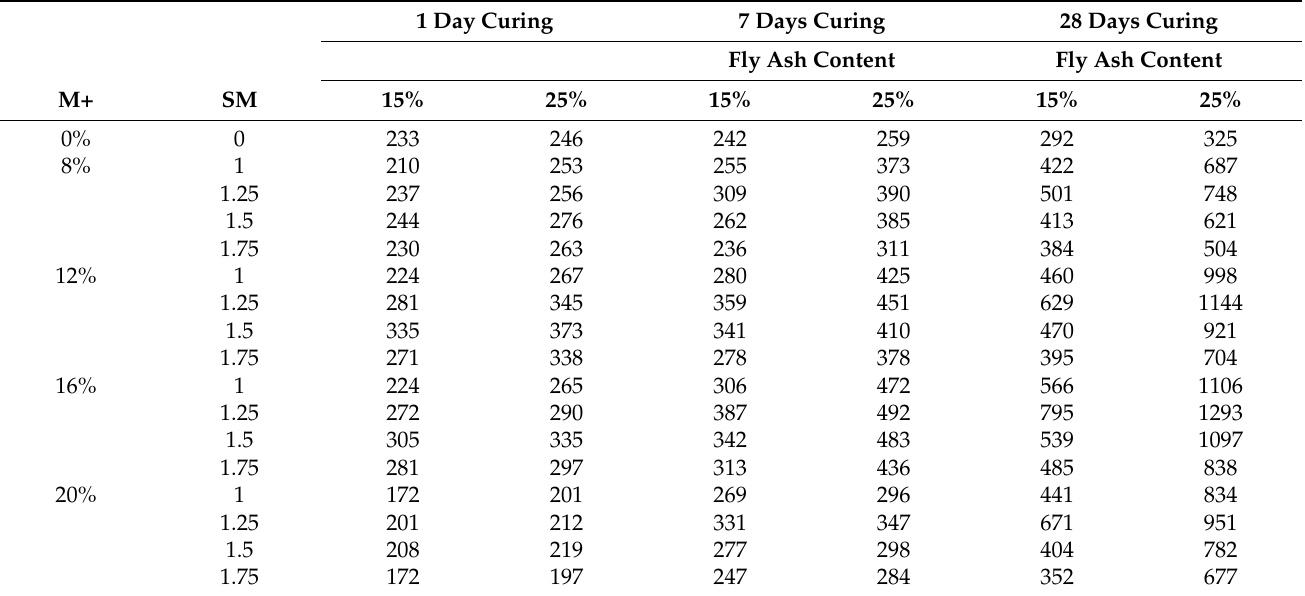
Table 2. UCS in kPa of soils stabilised with fly ash and with alkali-activated fly ash with different alkali dosages and silica